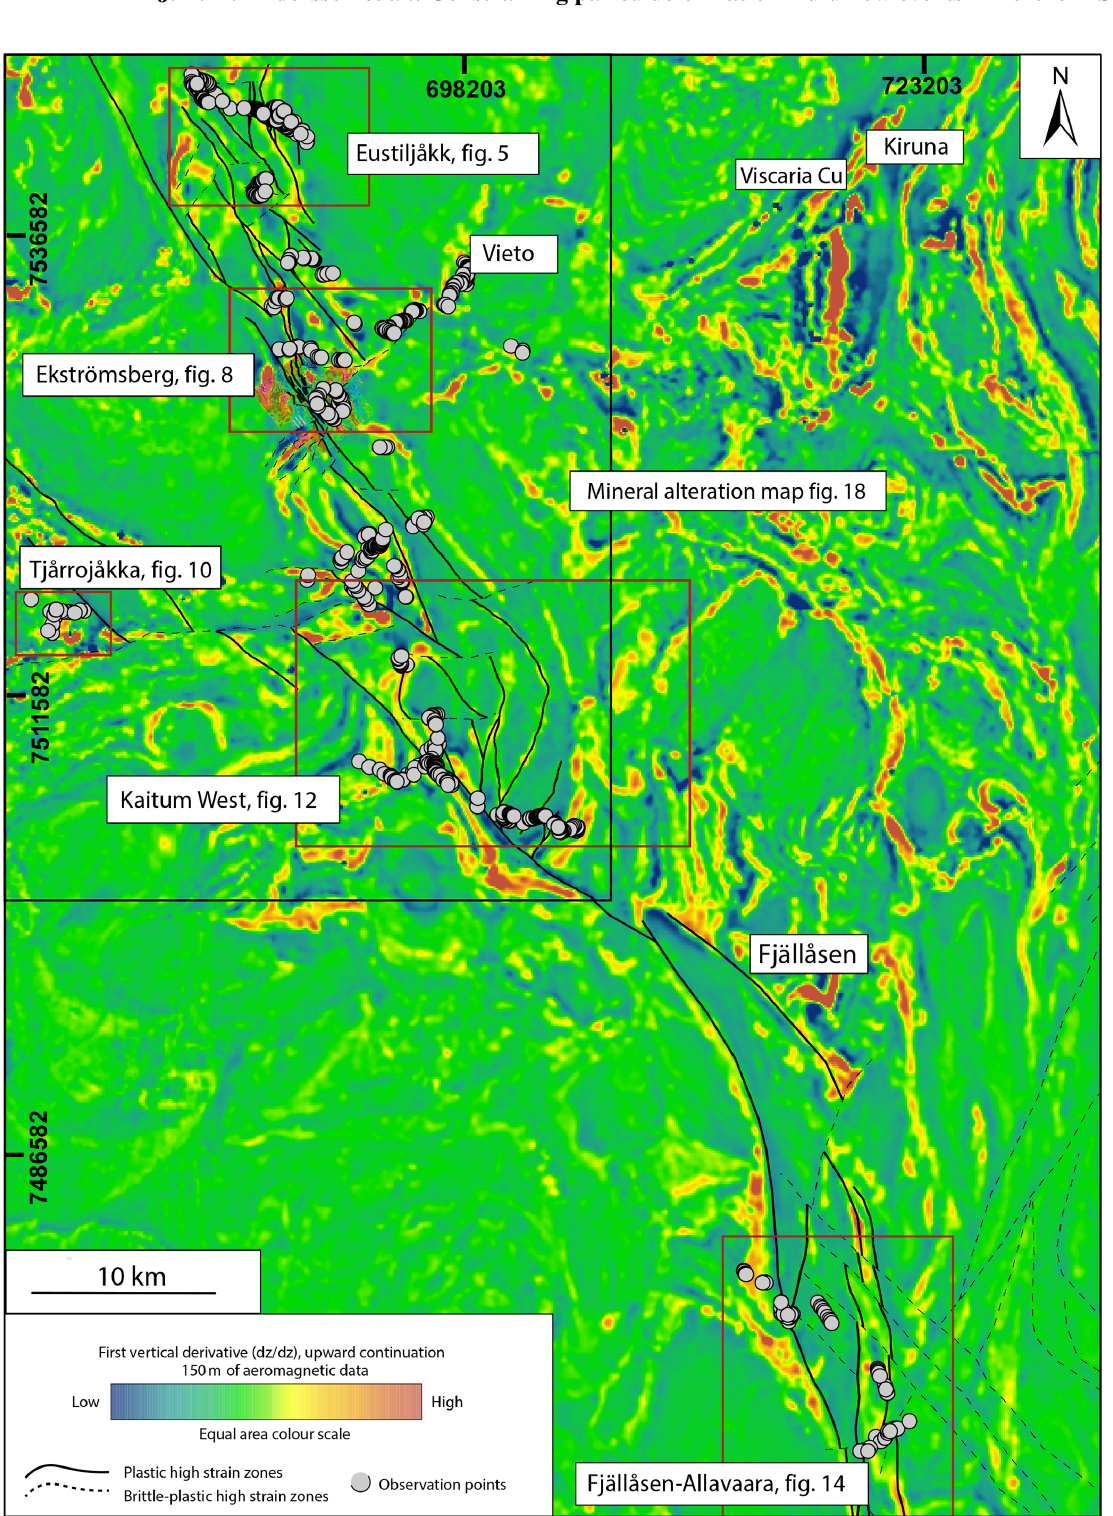
Figure 3. First vertical derivative, 150m upward continuation, aeromagnetic map of the Western Supracrustal Belt overlain by first vertical derivative ground magnetic map of Ekströmsberg. The aeromagnetic data were collected using 200m line spacing and 40m down-line distance (Bergman et al., 2001). The ground magnetic data were collected using ≤ 80m line spacing and ≤ 20m down-line distance (Frietsch et al., 1974). Outline of the key areas, observation points, and dominant structures are the same as in Fig. 2. Data from Frietsch et al. (1974) and Bergman et al. (2001). Coordinates: